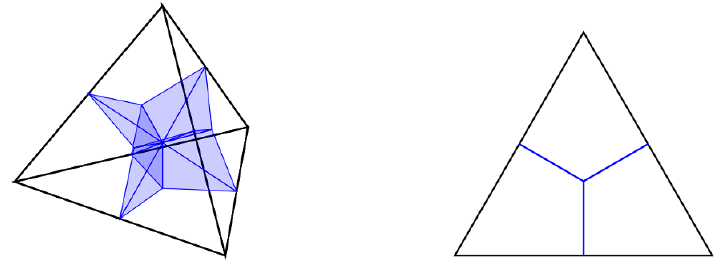
Figure 2 . This (cid:12)gure shows the polytope that represents the S 7 (left) where we have performed the cut that gives four pieces of S 1 (cid:2) C 3 . On the right one can (cid:12)nd a projection of the polytope to one of the sides where j z i j 2 = j z j j 2 = 0 for two speci(cid:12)c i 6 = j . Then the picture reduces to the 5D